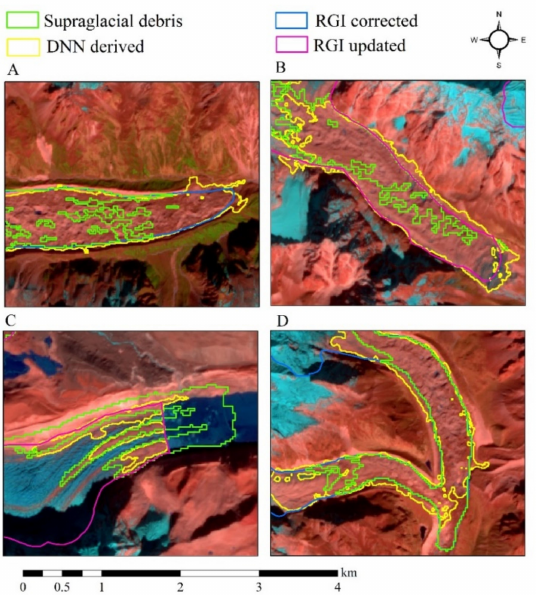
Figure 11. Visual comparison of the results derived by the proposed algorithm with the available ref- erence data. RGI-corrected data show a corrected glacier boundary on ~2015 satellite data by Herreid and Pellicciotti [72]. The RGI updated shows our minor corrections to Herreid and Pellicciotti [72] glacier boundary as per scene characteristics. Supraglacial debris data exhibit the supraglacial debris extent by Herreid and Pellicciotti [72], and DNN-derived shows the results of the proposed